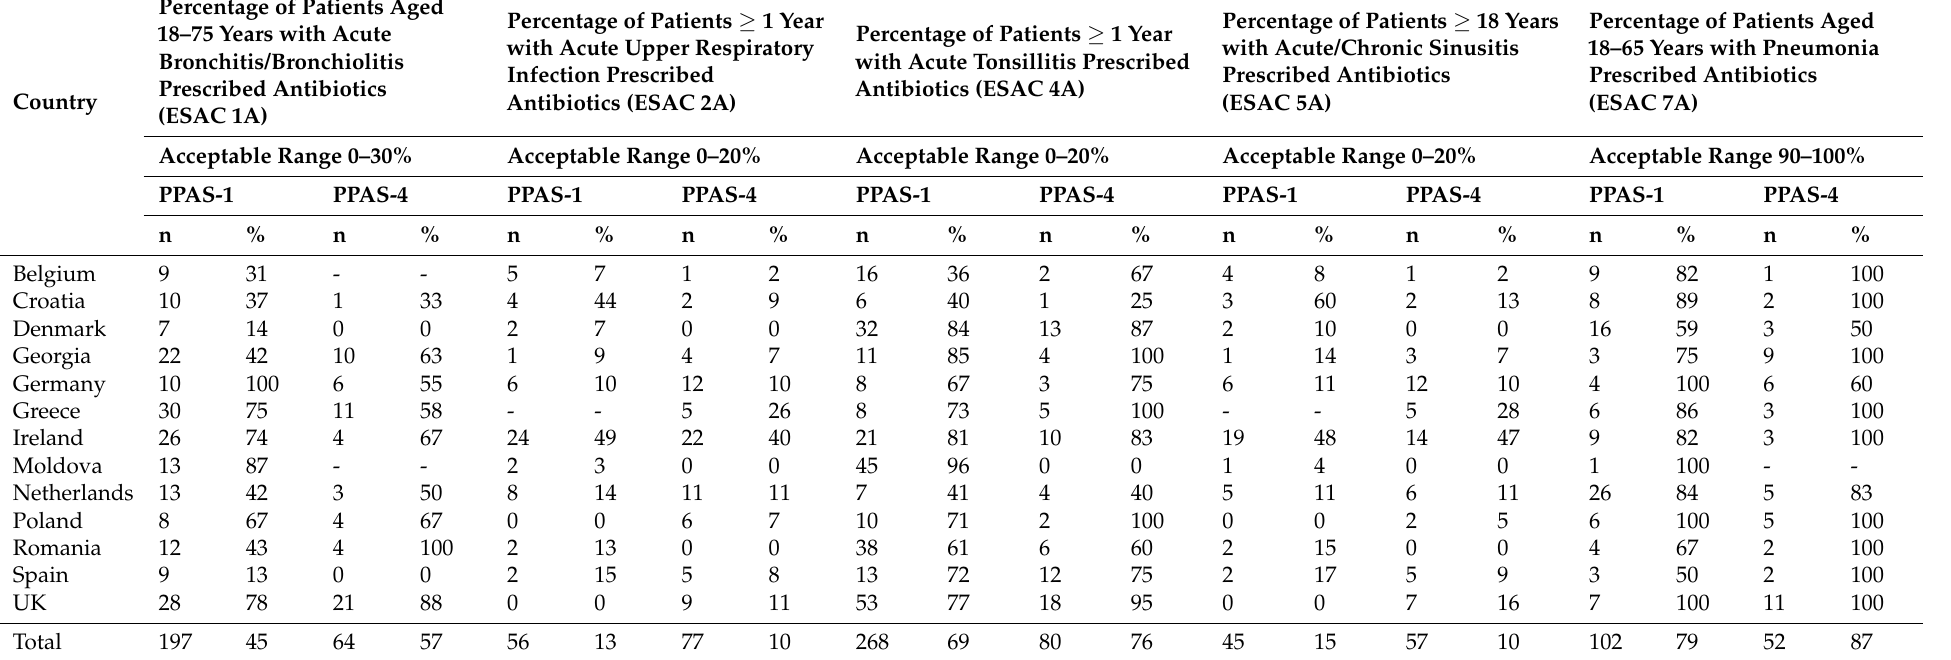
Table 3. ESAC Quality Indicators by country for PPAS-1 (2020) and -4 (2022). Highlighted are the percentages that exceed the acceptable range for each